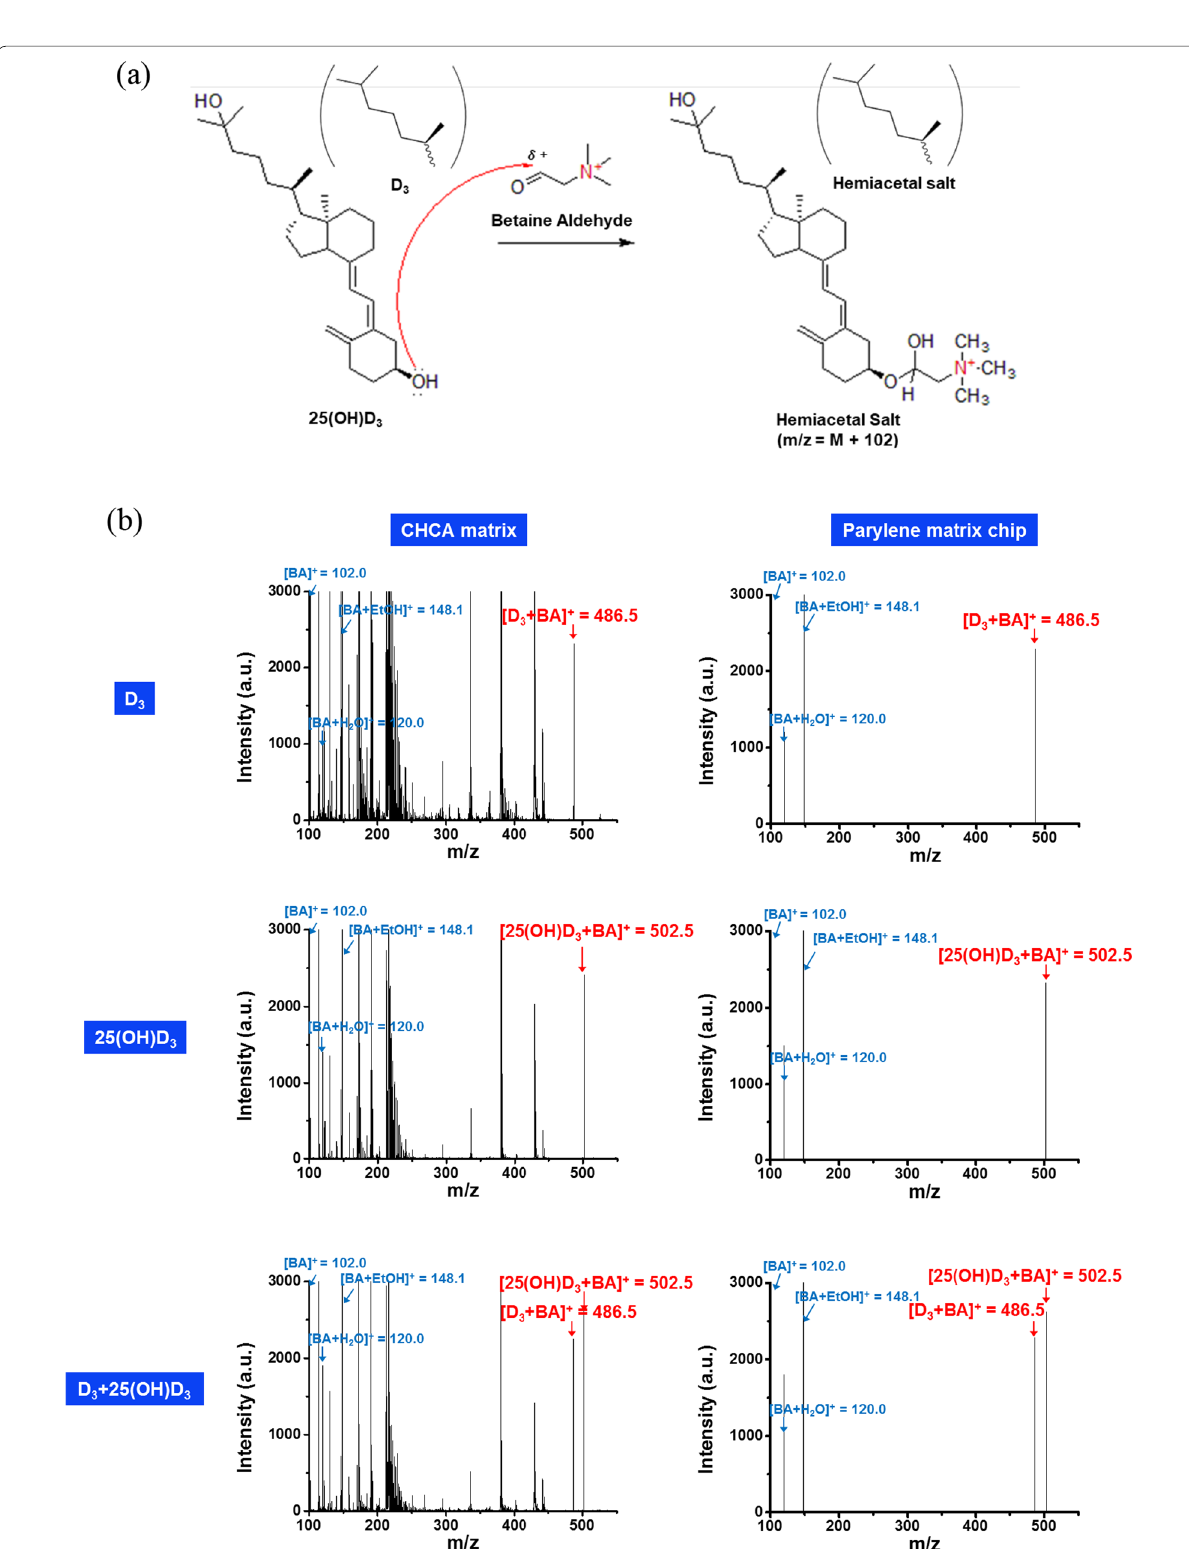
Fig. 3 Chemical derivatization of vitamin D . a Reaction diagram between the betaine aldehyde cation and the hydroxyl group of an alcohol in vitamin D. b Comparison of CHCA matrix and parylene matrix chip for the analysis of vitamin mixtures after BA derivatization. c Reaction diagram of the acid‑induced degradation and the mass spectrum of the product of derivatization. d Reaction diagram of PTAD and vitamin D and the mass spectrum of the product of PTAD